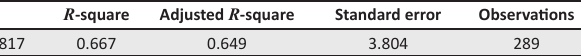
TABLE 5: Strategy formulation and long-term financial performance model summary. R